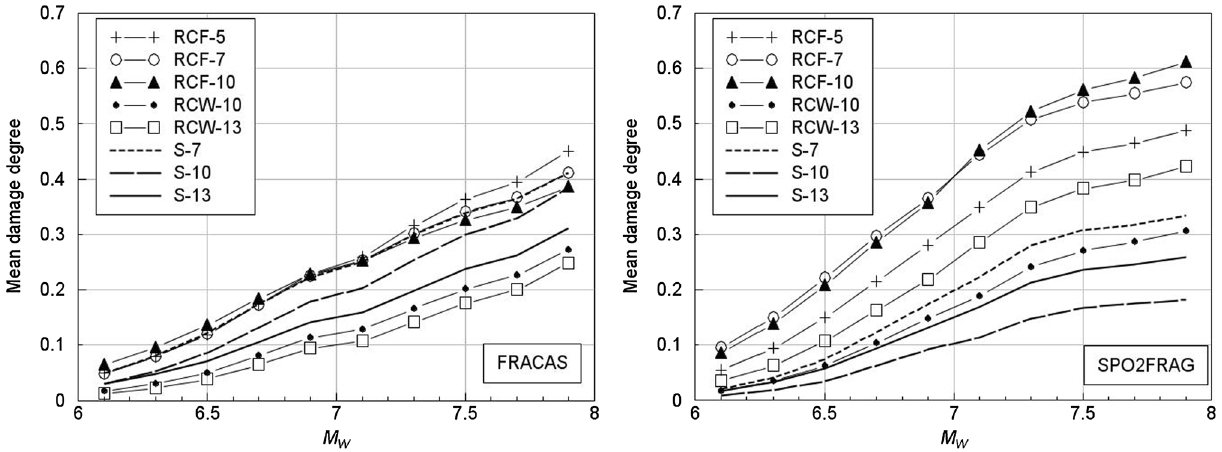
Fig. 9 Comparison of the mean damage degrees for each class of structures in Bucharest, Romania, using the FRACAS and SPO2- FRAG methodologies as a function of earthquake magnitude (left–